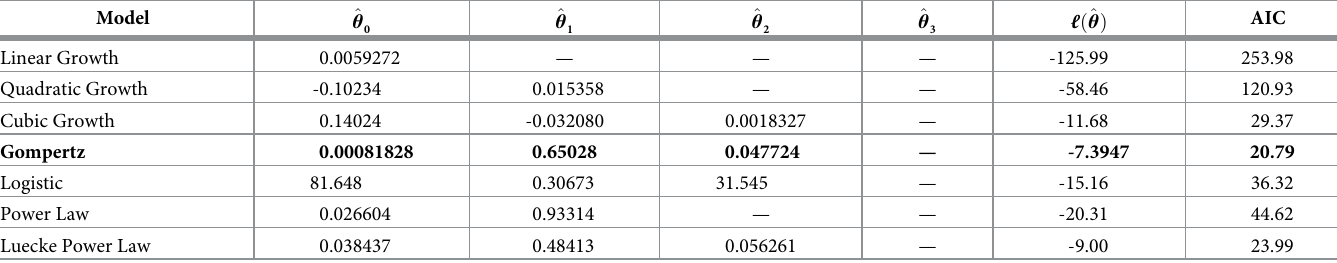
Table 23. Fetal gut mass models (g vs. fetal mass in g for power law models, g vs. gestational age in weeks for all other models).